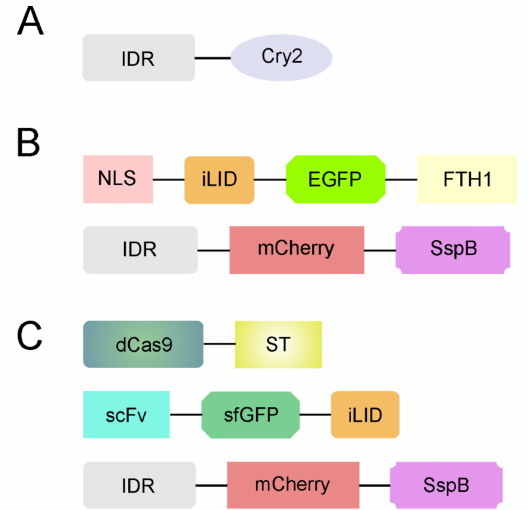
Figure 3. The basic modules of optogenetic tools use to investigate phase separation. Schematic diagram of the ( A ) optoDroplets [112], ( B ) Corelet [114], and the ( C ) CasDrop system [113]. For details, see the